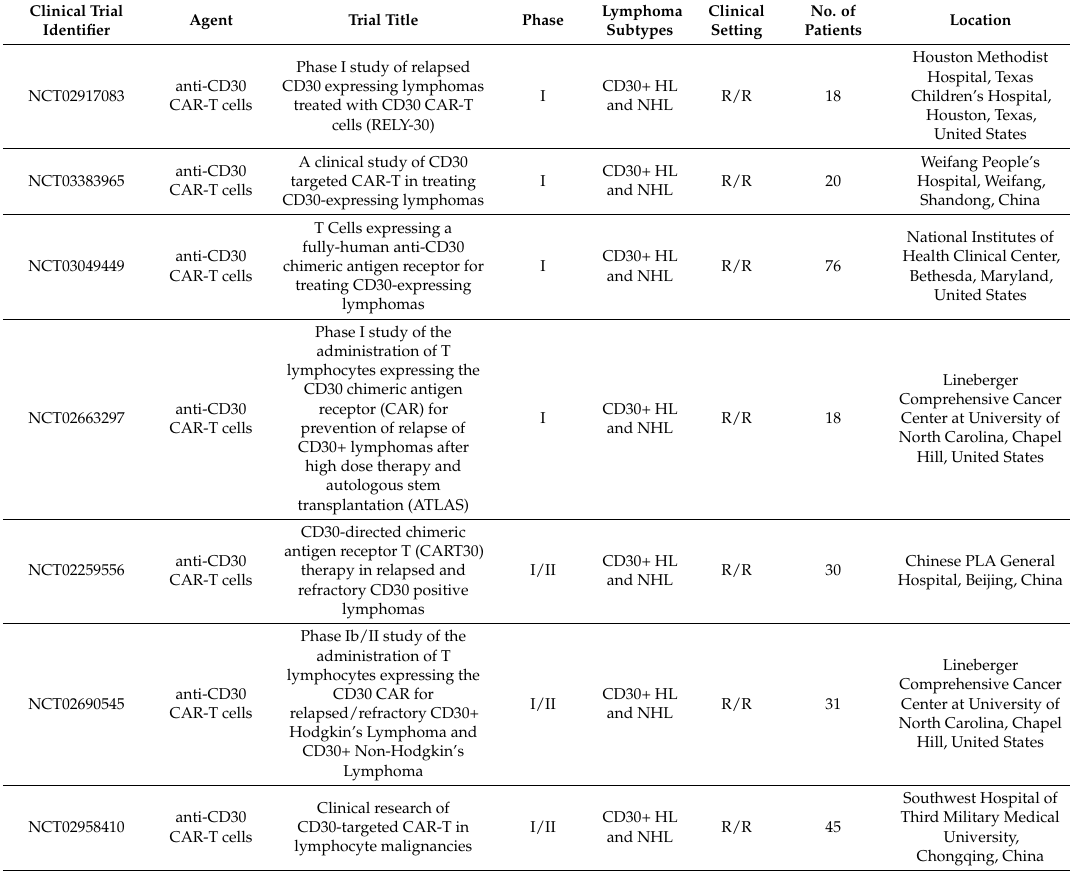
Table 4. Open clinical trials of anti-CD30 CAR-T cell therapies in T-NHL. Clinical Trial